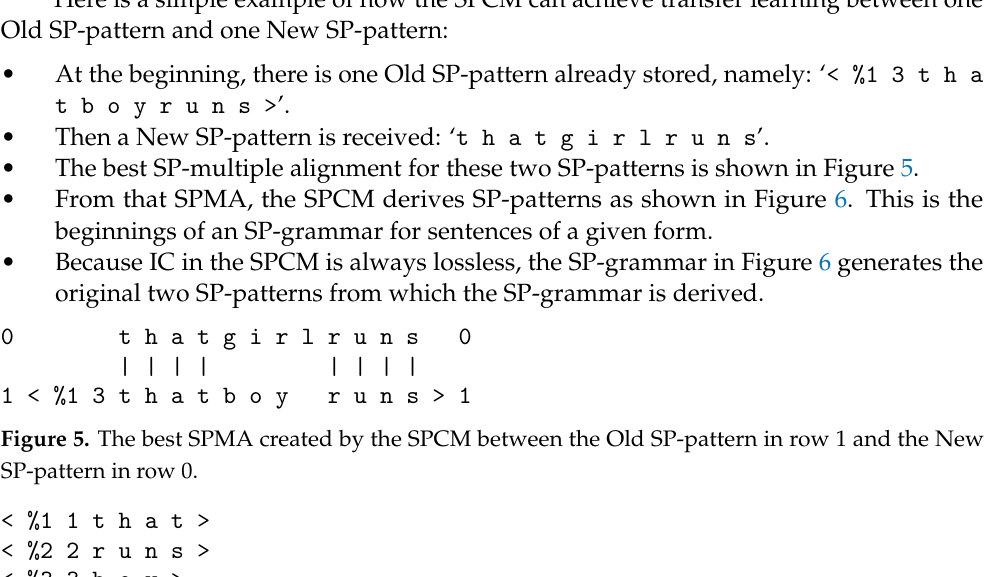
Figure 6. The SP-grammar created by the SPCM from the SPMA shown in Figure